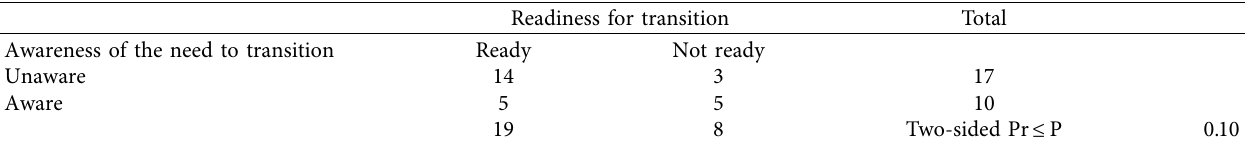
Table 2: Fisher’s exact test of the association between awareness of the need to transition and readiness for the patient to transition to adult- based